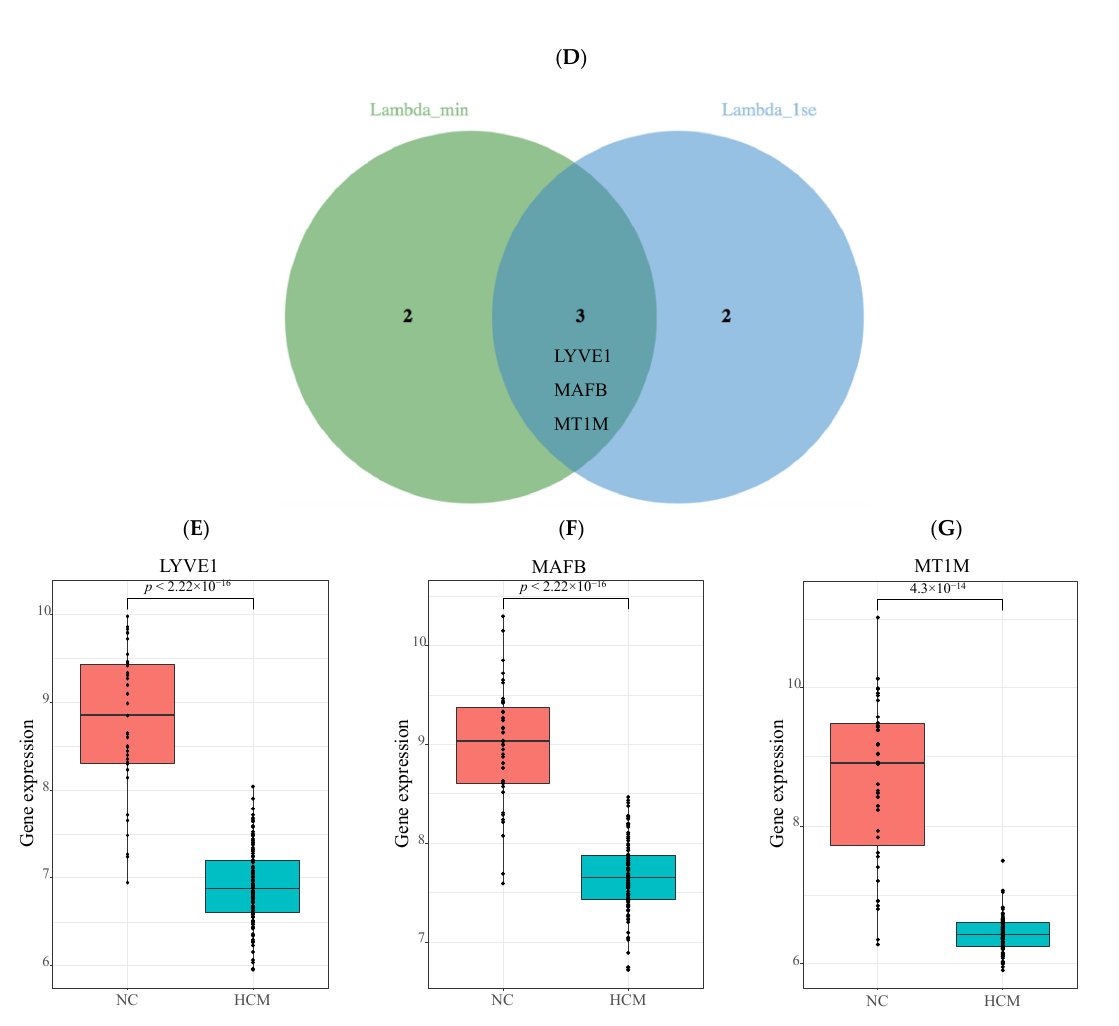
Figure 4. LASSO model establishment and key genes identification. ( A ) The optimal lambda selection in LASSO model. The left dotted line represented lambda.min, and the right dotted line represented lambda.1se. ( B ) Receiver operator characteristic (ROC) curves in train set. The blue line represented the ROC curve calculated based on the value of lambda.min, and the red line represented the ROC curve calculated based on the value of lambda.1se. ( C ) ROC curves in test set. ( D ) Three common key genes screened from two LASSO models are shown in Venn diagram. ( E – G ) Differential expressions of key genes in GSE36961 dataset. ( E ): The differential expression of LYVE1 between HCM and control groups; ( F ): The differential expression of MAFB between HCM and control groups; ( G ): The differential expression of MT1M between HCM and control groups. All p < 0.001.